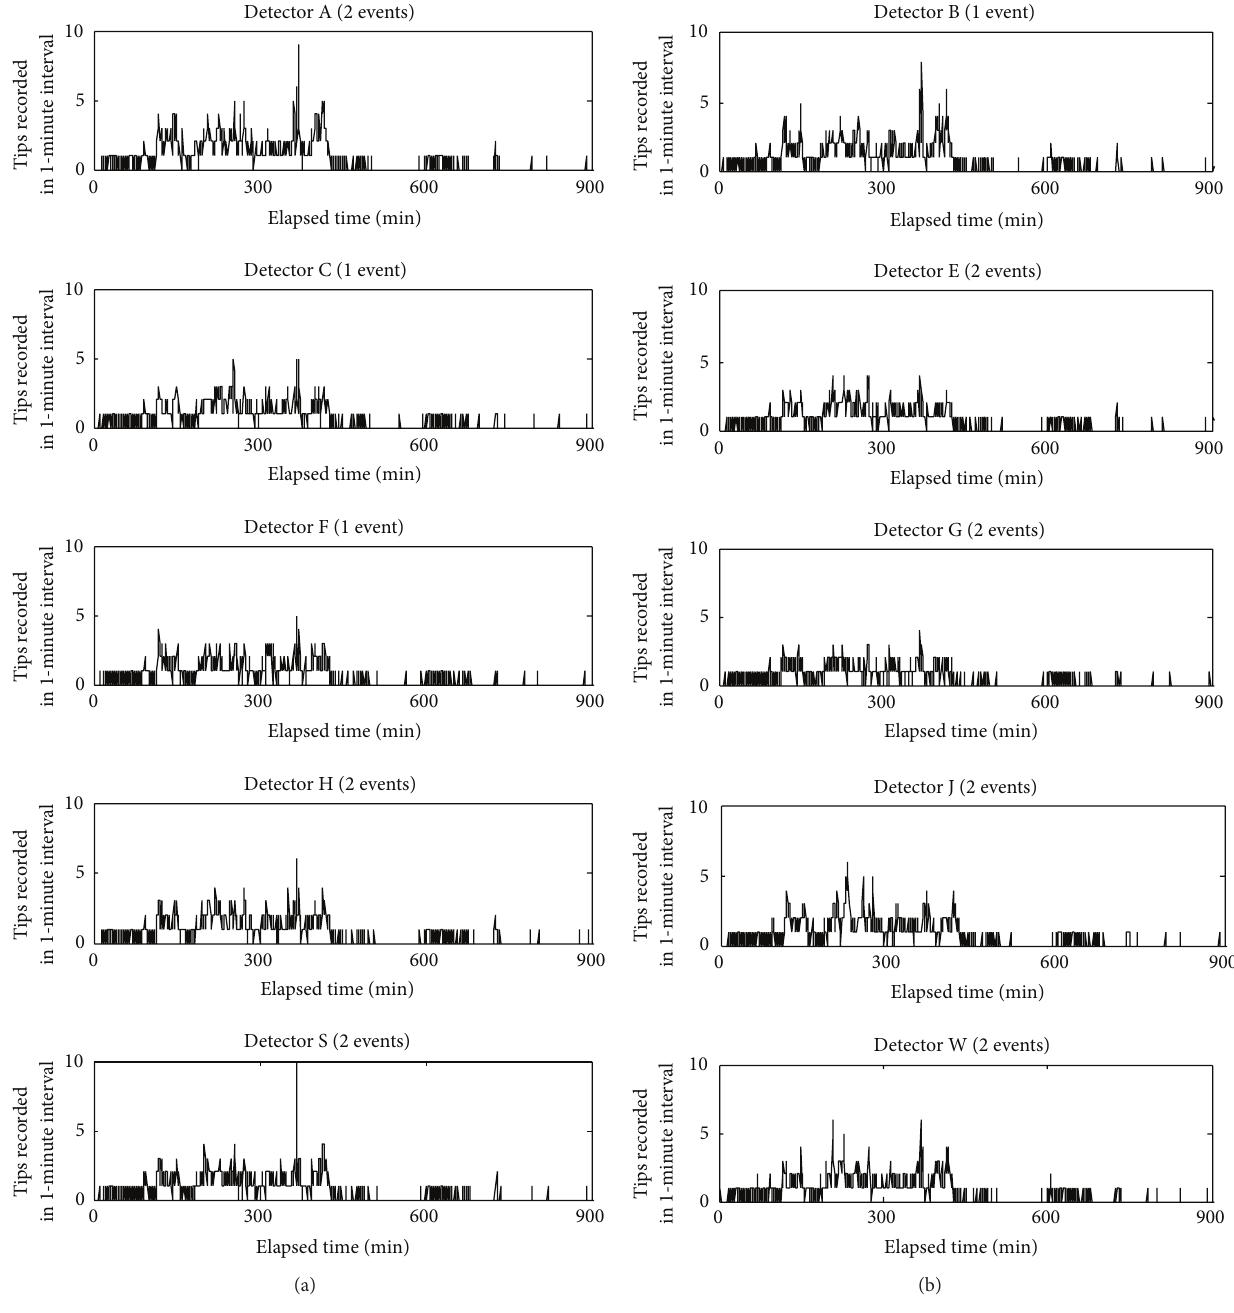
Figure 6: An illustration showing how extremely similar data records can sometimes be partitioned into events differently. Here, an intense rain event trails off to a drizzle. However, this slight drizzle is just enough to finish a single tip (over a one-hour period) in detectors B, C, and F. Other detectors less than 5 meters away did not accumulate exactly the same amount of rainfall and thus did not have this tip occurring during the mostly quiescent period. Consequently, 3 of the 10 detectors see one long (but highly variable) event while the other 7 detectors see 2 separate events—even though realistic values for MIT (1 hour) and L (15 minutes with detection) are used.